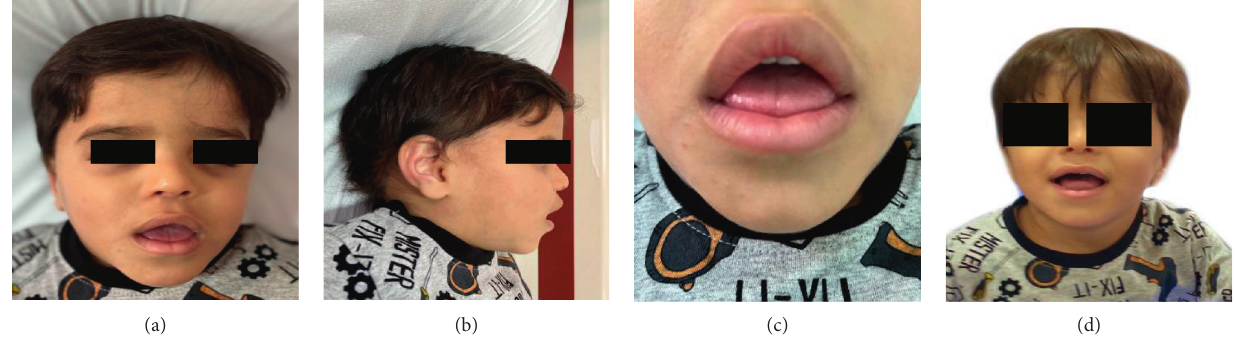
Figure 1: Patient’s face and tongue showing facial dysmorphic